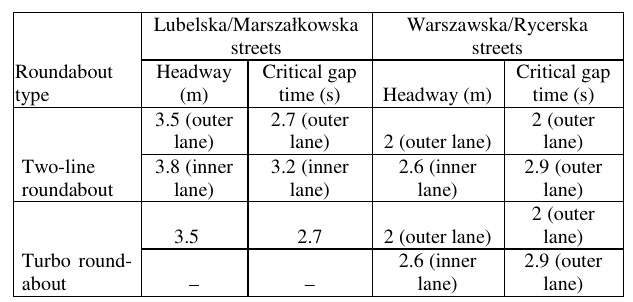
Table 2. Priority rules for the simulation